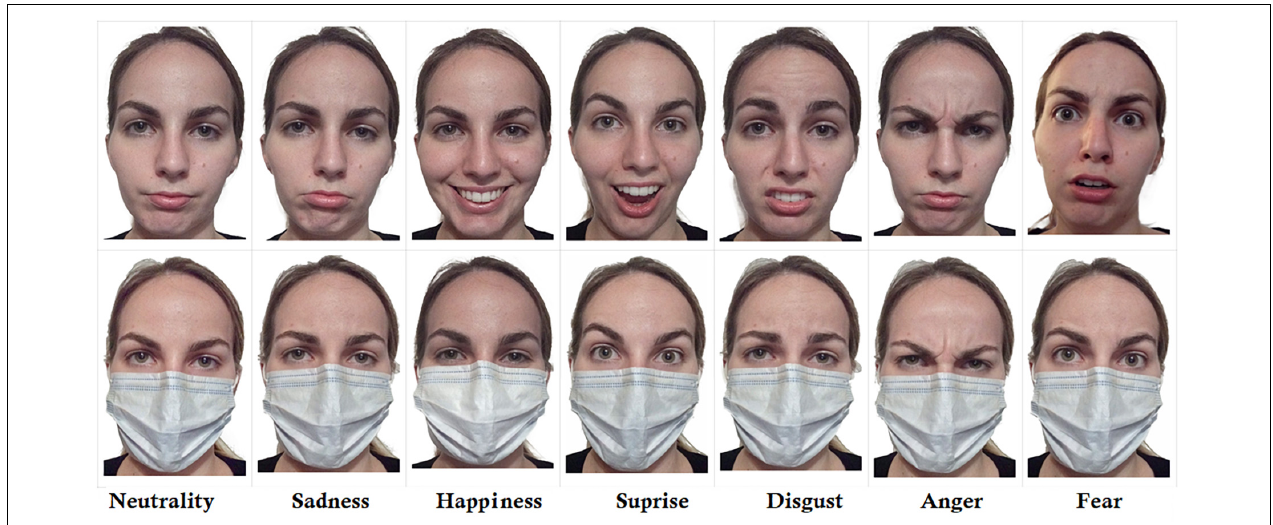
FIGURE 1 | Example of stimuli (facial expressions) in the natural and masked condition. Overall, stimuli were created by taking photographs of natural expressions of eight actors (four male and four females) concentrated on their inner imaginary emotional state, through the Stanislavsky method. Masks were worn in reality and not digitally recreated. This revealed, for example the mouth/lips contraction associated with anger, the large mouth opening associated with disgust, the air intake (inhalation) characteristic of surprise or fear resulting in evident mask sucking.